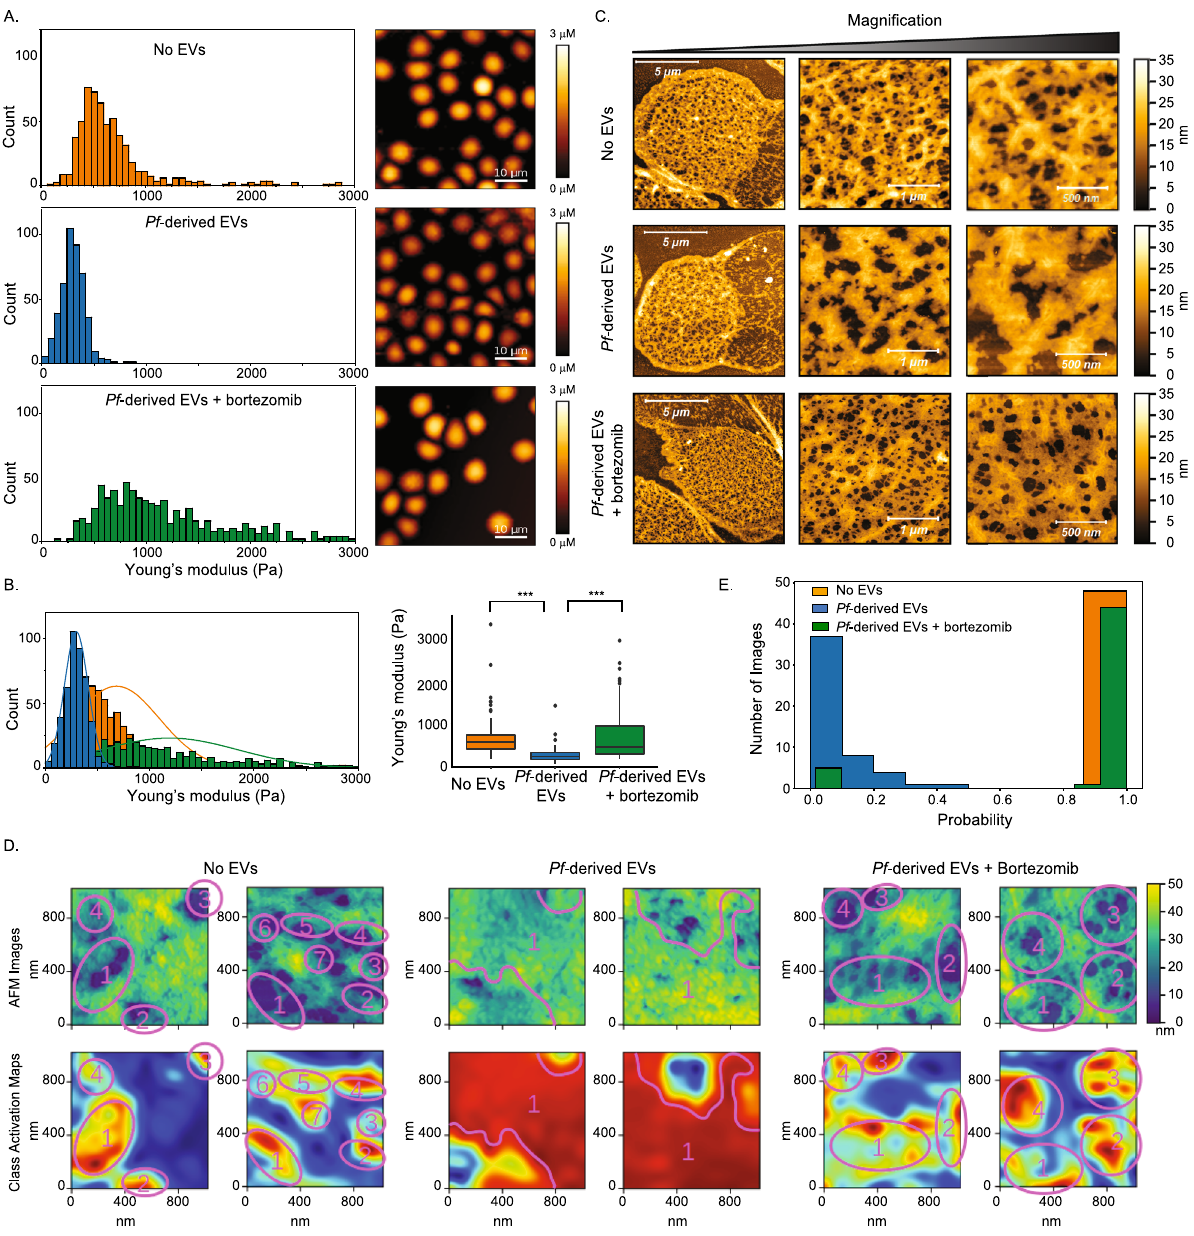
Fig. 4 EV-20S proteasomes modulate the mechanical properties of RBCs. A Mechanical changes measured by AFM following Pf -derived EV incubation with naïve RBCs. Pf -derived EVs or Pf -derived EVs pretreated with proteasome inhibitor (bortezomib) were incubated with naïve RBCs. Pretreated cells were deposited on a mica surface for AFM topography and mechanical measurements. Distributions of Young ’ s modulus values shown in the left panel, each count in the histogram represents data from a separate indentation, nine different positions were measured near the center of each cell. Representative AFM images are shown in the right panel (scale bar 10 µ m). B Superposition of the Young ’ s modulus distribution (left panel) and box plot of the average value from the four different experiments (right panel). Boxes represent the 25 – 75 percentiles of the sample distribution, with black vertical lines representing the 1.5 × IQR (interquartile range). The black dots represent outliers. Black horizontal line represents the median. Signi fi cance was calculated using one-way ANOVA, followed by a Tukey post hoc test. For A and B three independent experiments were performed, each comparing naïve RBCs, and naïve RBCs treated with Pf -derived EVs in the presence or absence of bortezomib, with total of 15 full images acquired for each condition. Number of cells measured were for No EVs n = 86, Pf -derived EVs n = 103, Pf -derived EVs + bortezomib n = 95, p <0.001. C Representative AFM images recorded in air showing the cytoskeletal structures of naïve RBCs, naïve RBCs treated with Pf -derived EVs in the presence or absence of bortezomib. Three independent experiments were performed, with a total of 50 AFM scans for each type of cell treatment. D Demonstration of the CNN analysis discrimination. Two examples are shown for each cytoskeleton phenotype: uRBCs on the left, RBCs exposed to Pf -derived EVs without and with bortezomib treatment in the center and right, respectively. Top row shows AFM images and bottom row the class activation maps whereby discriminatory regions are red/yellow and uncorrelated or anti-correlated regions blue/green. Discriminatory regions are marked and labeled to guide the eye. It is clear that the “ hole ” regions are associated with healthy untreated RBC and RBC treated with Pf -derived EV and bortezomib and the “ backbone ” regions with the RBC affected with Pf -derived EVs. E CNN prediction, showing analysis made on the control set of naïve RBCs, and naïve RBCs treated with Pf -derived EVs in the presence or absence of bortezomib (proteasome inhibitor). The x -axis represents the probability for an image to resemble the uRBC control. The y axis represents the number of images in the analysis for a class type (untreated RBC, Pf -derived EV-treated RBC, and RBC treated with Pf -derived EV and bortezomib) which conforms to a given probability. The no EV and Pf -derived EV data is from the testing set.